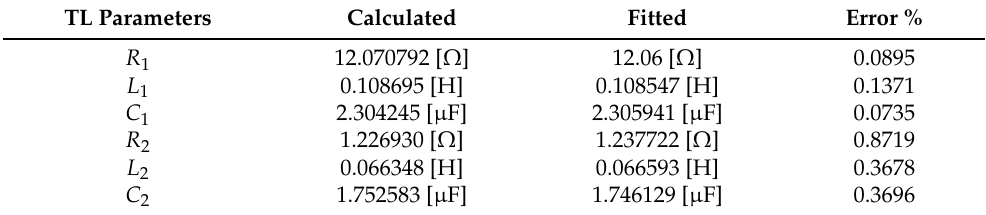
Table 7. The calculated and fitted parameters of the proposed model for Z 11 .